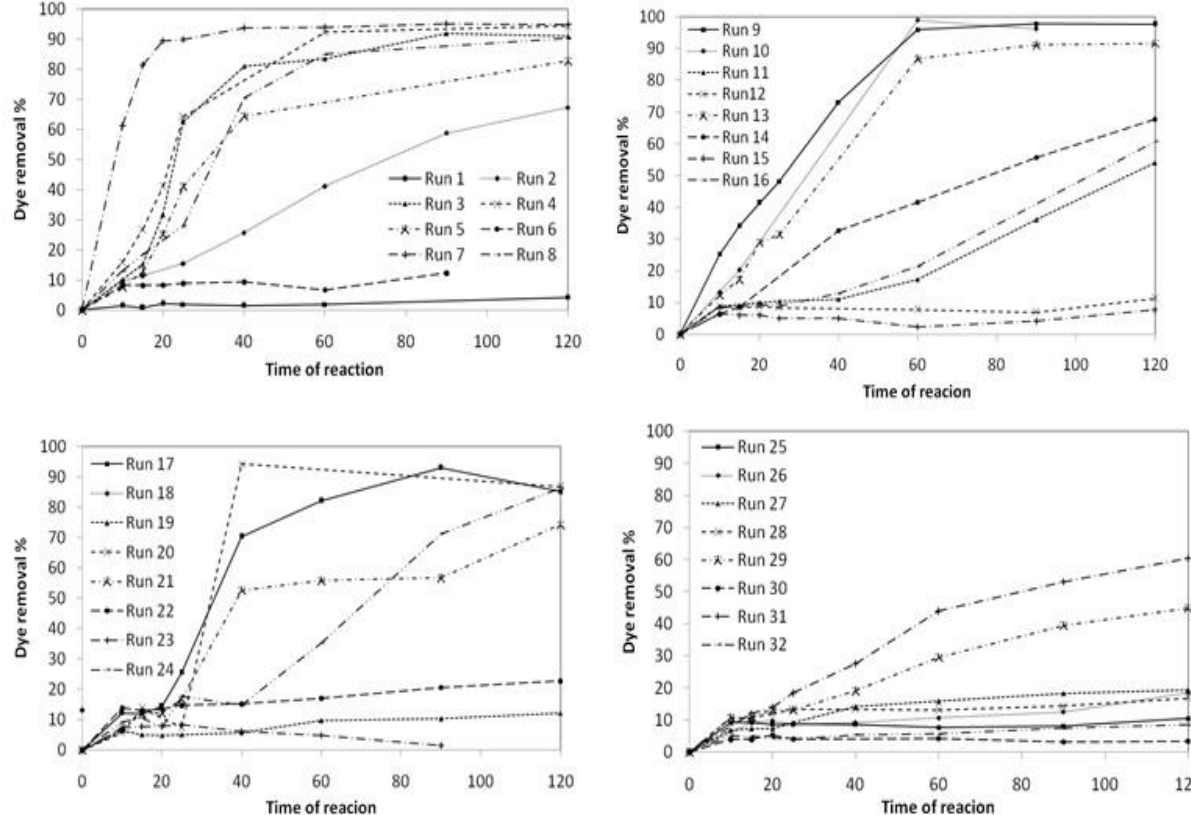
Figure 2. The experimental dye removal efficiency (DR%) results of 32 runs Multiple linear regression (MLR) and stepwise multiple linear regression (SMLR) were then applied parameters’ influences. The MLR model was developed for DR%, and the statistical details of the model are shown in table 3.